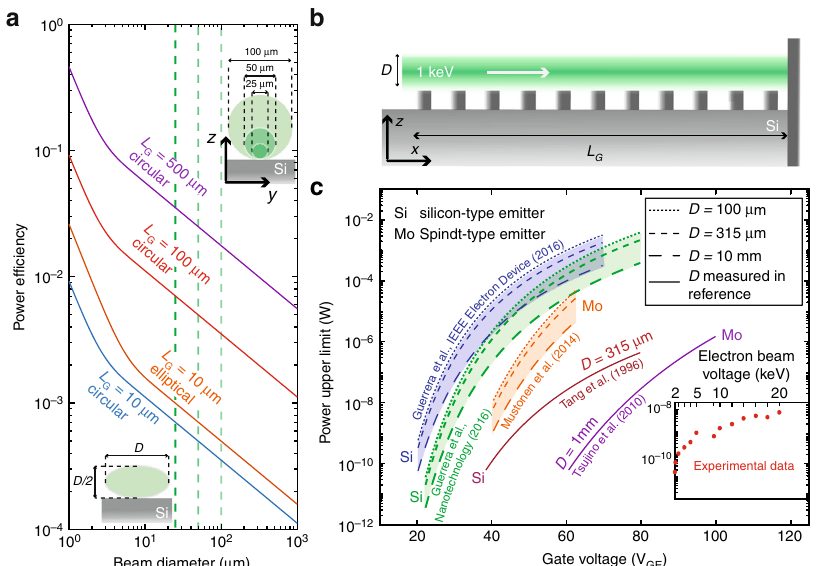
Fig. 4 Maximal ef fi ciency of all-silicon tunable sources in the near-infrared. a Calculated ef fi ciency of a single silicon emitter integrated with a silicon nanograting as a function of the electron beam diameter. The insets show the beam shape and alignment con fi guration with respect to the nanograting in this simulation. b (Illustration) Setup used to theoretically evaluate the maximal ef fi ciency of multiple FEA designs integrated into a SP source. c Calculated upper limit of the optical power as a function of the gate voltage for different FEA designs integrated with a 10 µ m long silicon grating. These different designs are all gated with the same range of voltages V GE (20 – 100 V). The inset shows our experimental results in a modi fi ed SEM setup as a function of the electron beam